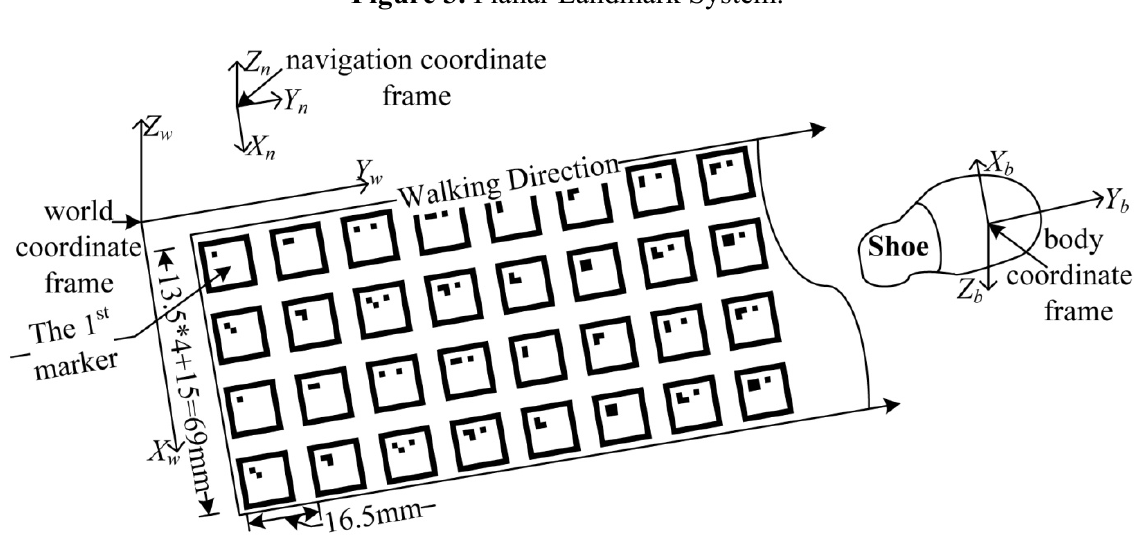
Figure 3. Planar Landmark